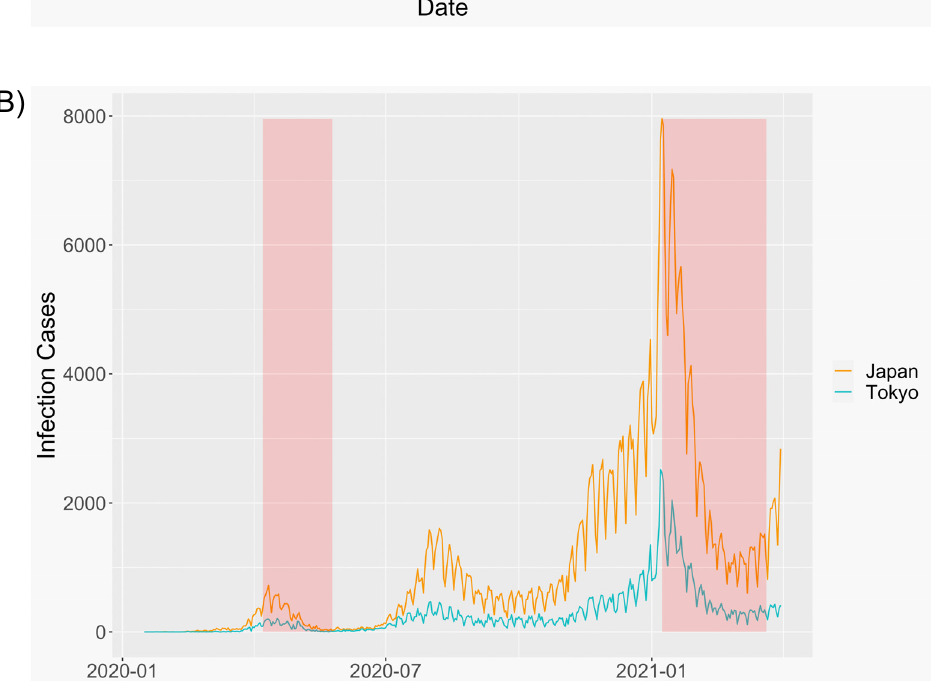
Fig 1. Infection cases in Tokyo MA (A) and entire Japan